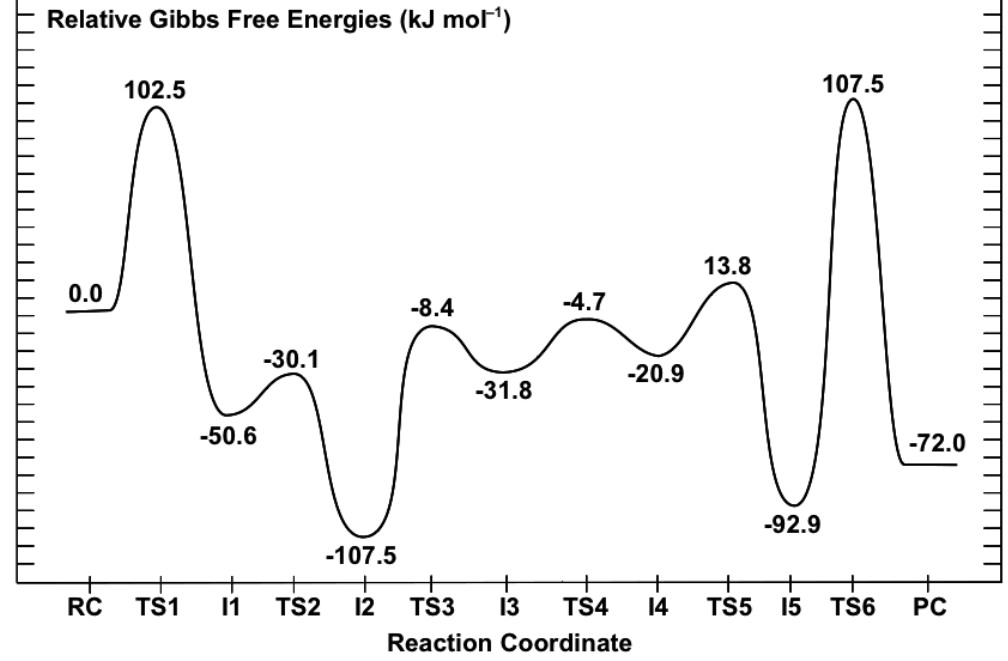
Figure 3. Overall PES for the catalytic mechanism of saccharopine reductase obtained at the ONIOM(HF/6-31G(d):AMBER94)-ME level of theory with inclusion of Gibbs corrections.